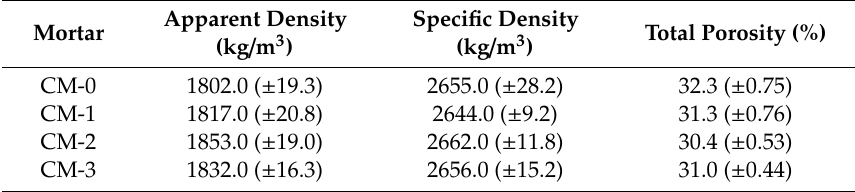
Table 3. Apparent density, specific density, and total porosity of the mortar (standard deviation in brackets) .